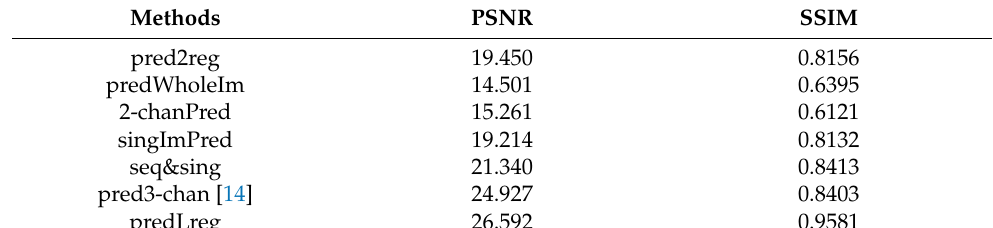
Table 12. Comparisons of various image prediction methods.